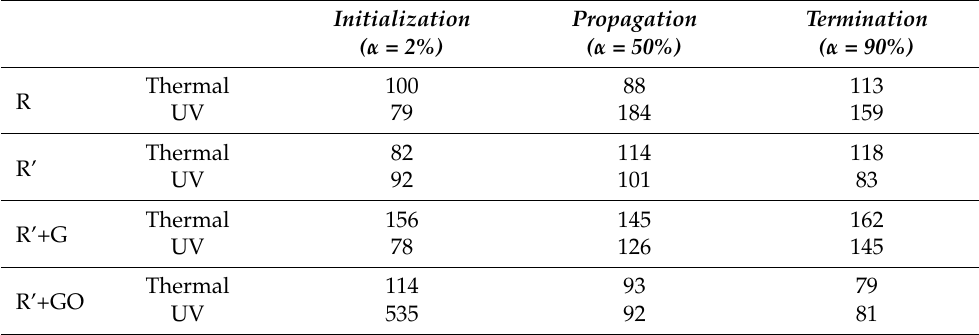
Table 12. Activation energy (kJ/mol) of thermally and UV-triggered